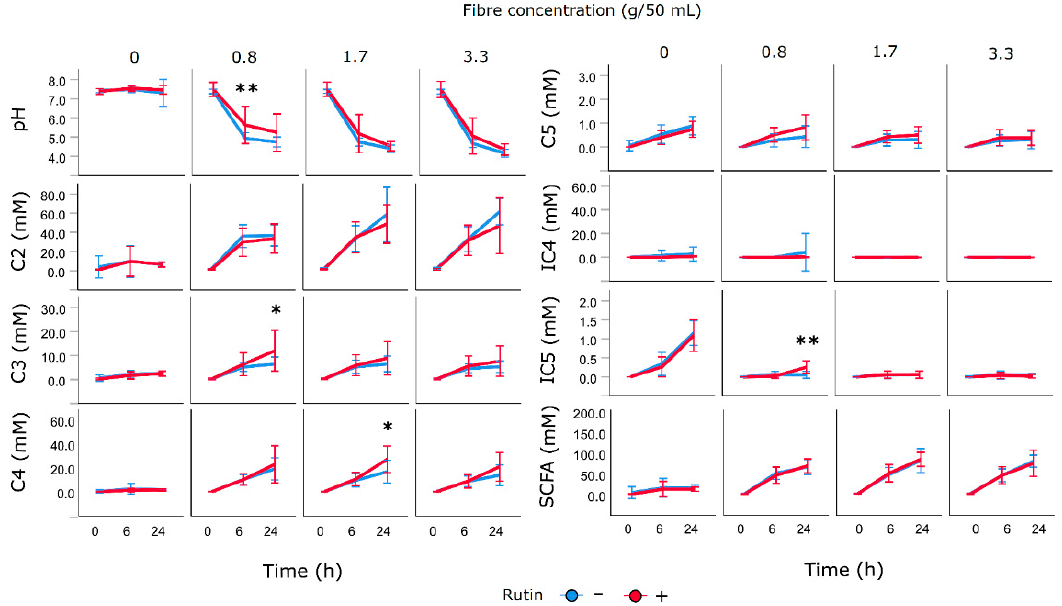
Figure 5. Effect of rutin on formation short chain fatty acid from inulin (3 concentrations) in faecal incubations; * significantly different ( p < 0.05), ** ( p < 0.01) between fermentation with rutin (red) and without rutin (blue) using independent samples t-test, adjusted for multiple comparisons, means ± SD for n = 10; C2, acetic acid, C3, propionic acid, C4, butyric acid, IC4, isobutyric acid, C5, valeric acid, IC5, isovaleric acid.